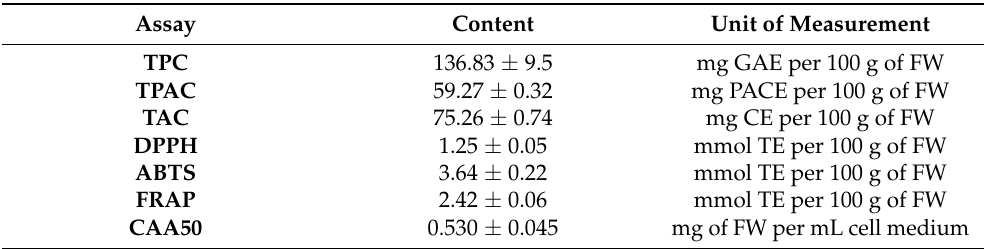
Table 2. Total content of polyphenols, proanthocyanidins, and anthocyanins of Eugenia involucrata fruit extract along with its radical-scavenging (DPPH and ABTS), metal-reducing (FRAP), and cellular antioxidant